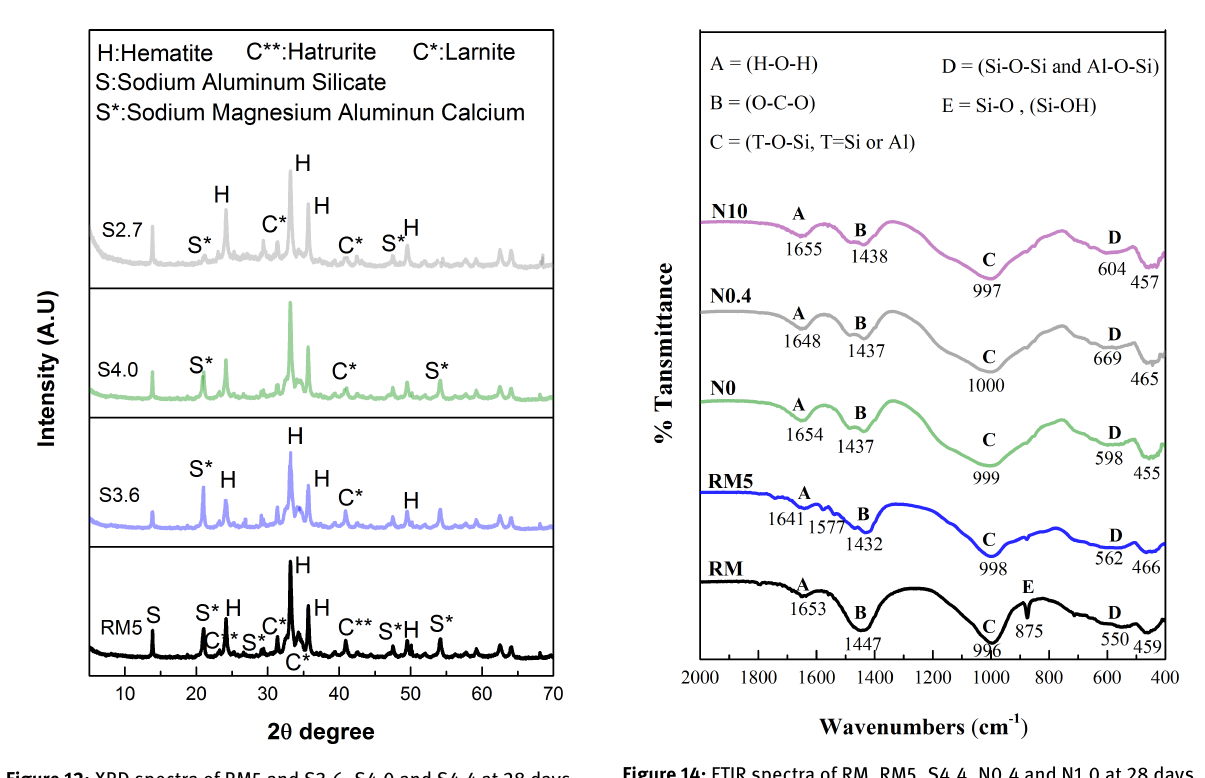
Figure 12: XRD spectra of RM5 and S3.6, S4.0 and S4.4 at 28 days